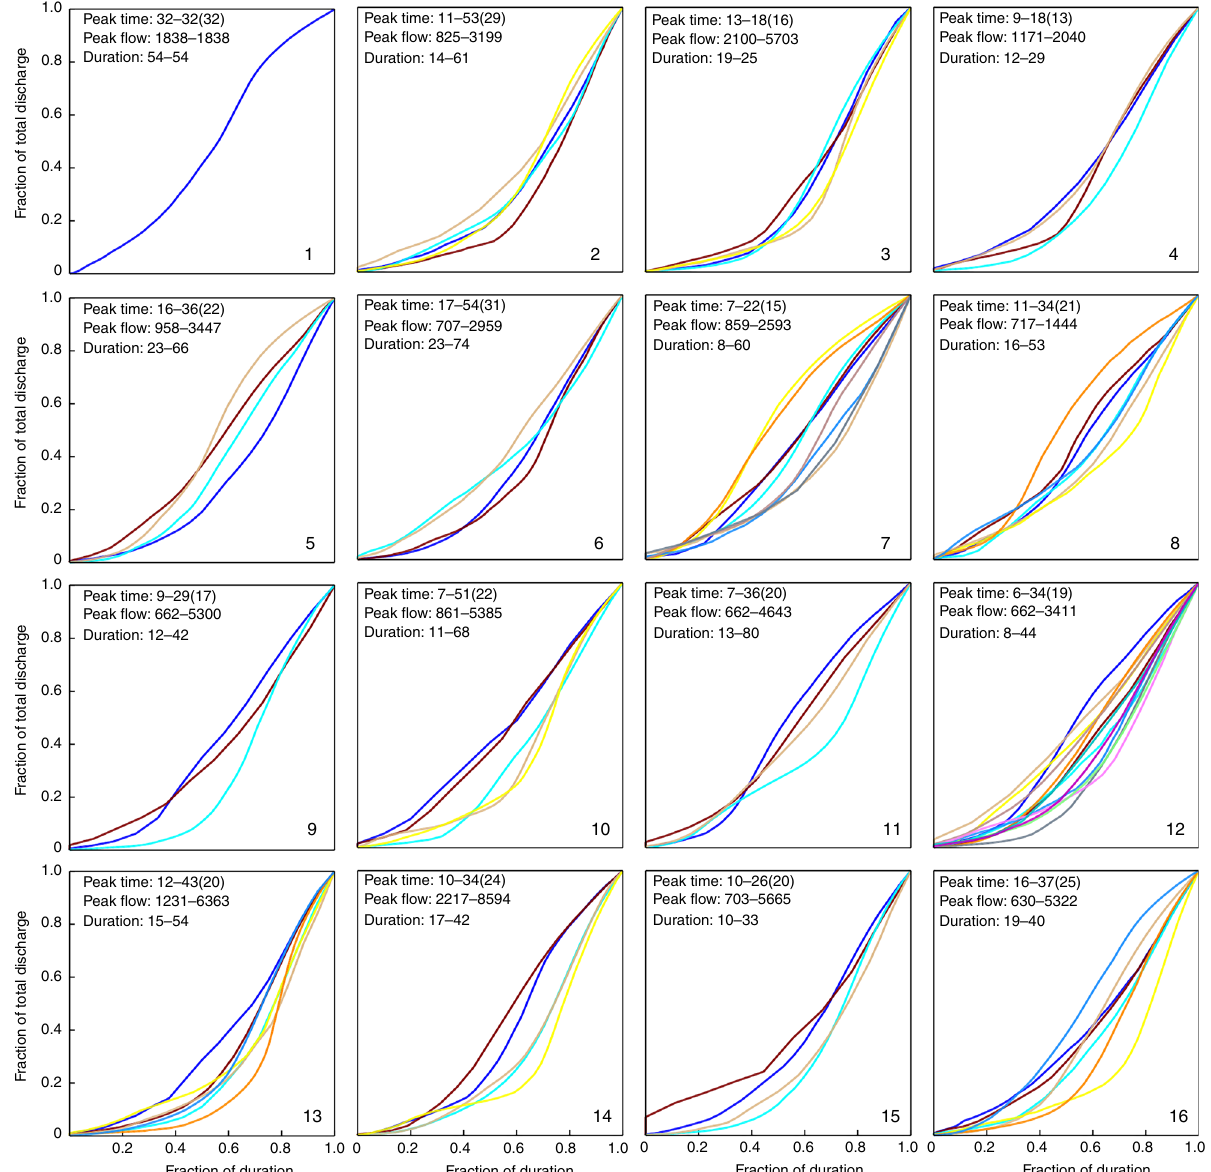
Fig. 6 Normalized fl ow characteristic curves using the third typhoon duration scheme. The third scheme determining typhoon duration spans between the start rising limb characteristics and the cessation of